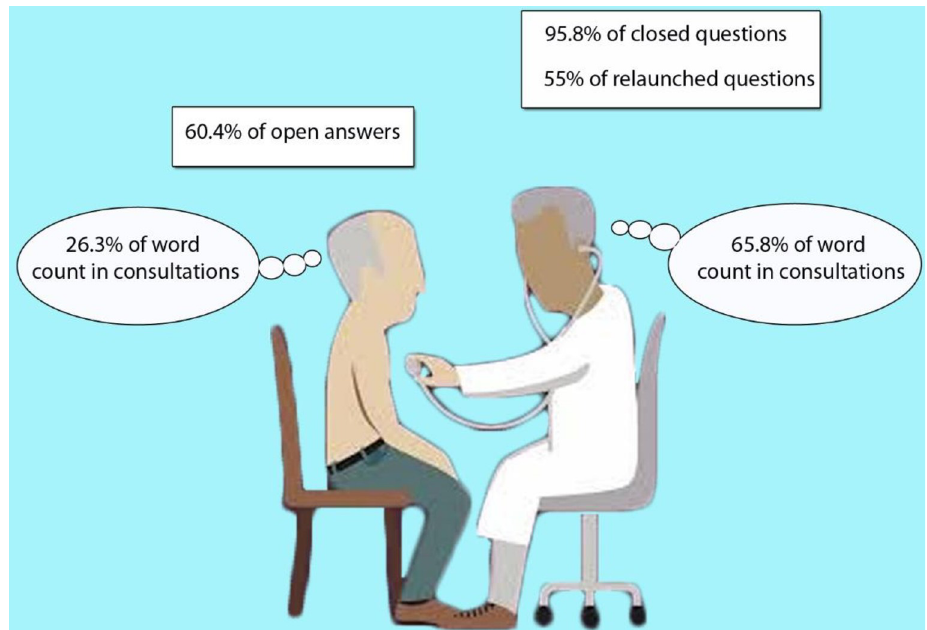
Fig 2. Summary of main results on communication flow in observed